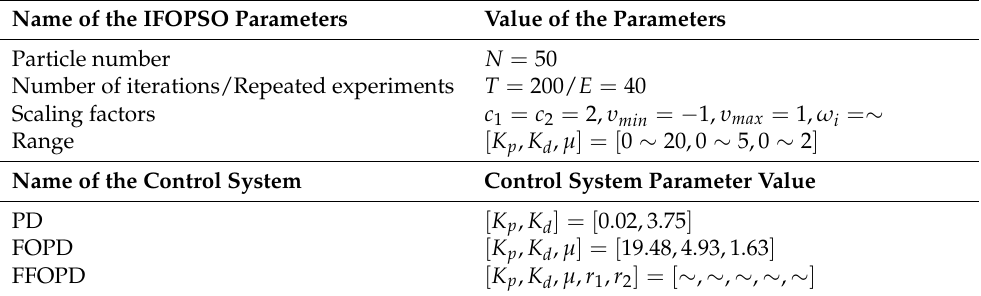
Table 6. Control system